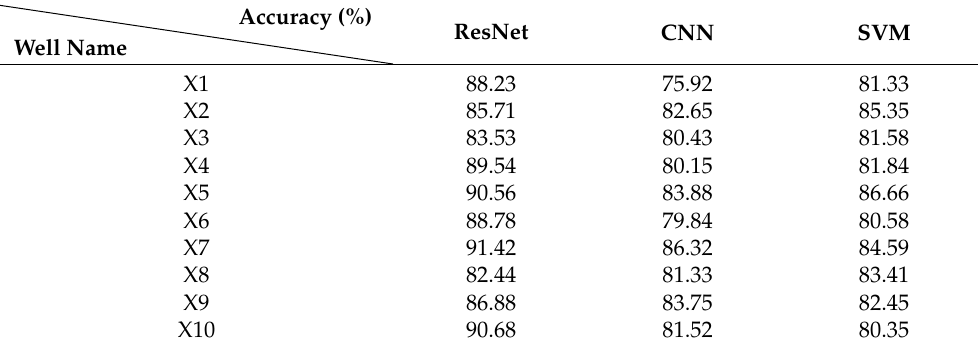
Table 4. Identification accuracy of different